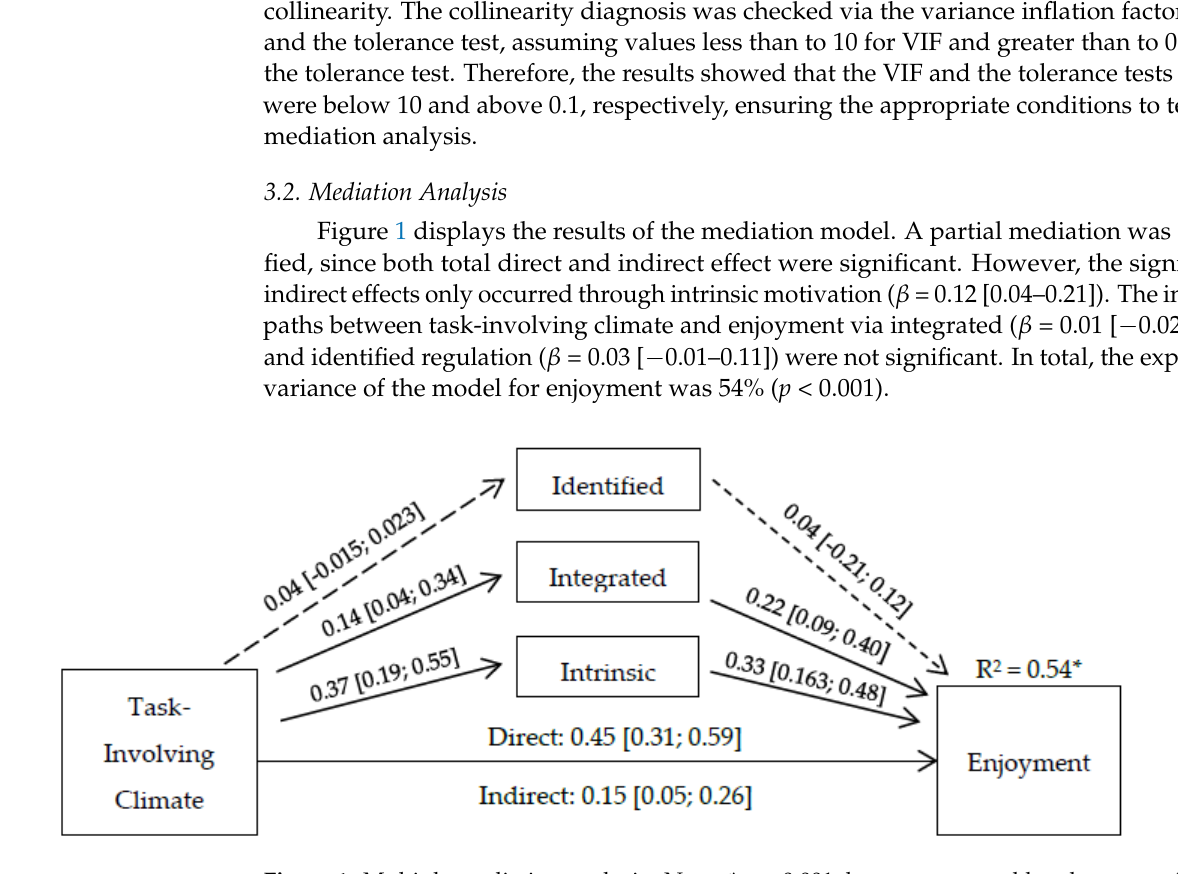
Table 1. Range, means, standard deviation, and bivariate correlation across the studied variables.